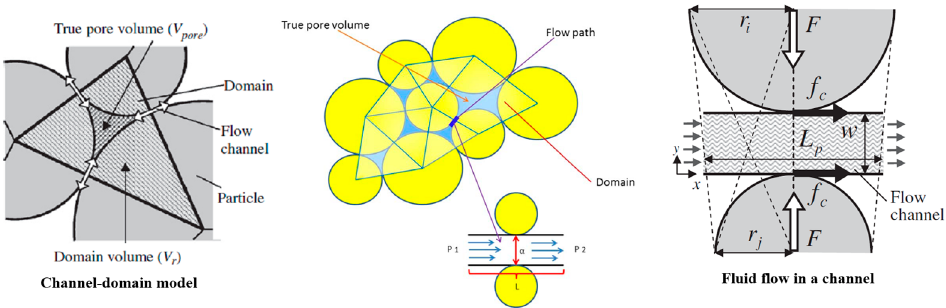
Figure 4. Flow model in a bonded assembly of particles.